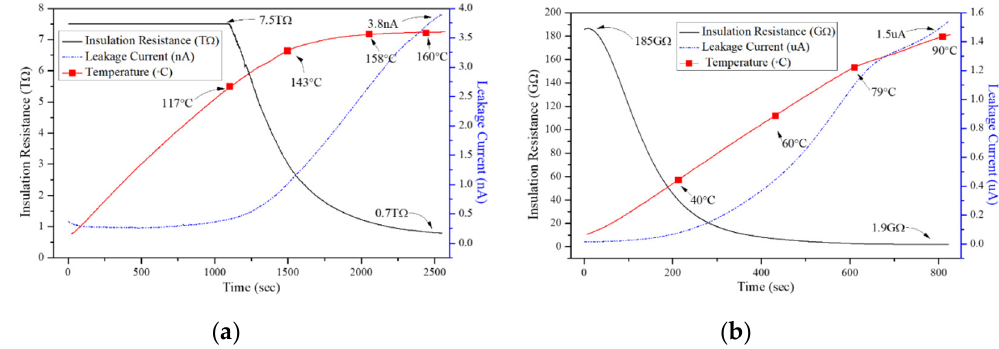
Figure 5. Insulation resistance and leakage current characteristics according to temperature ramp test of the cables. ( a ) TFR-8 cable, ( b ) VCTF cable.